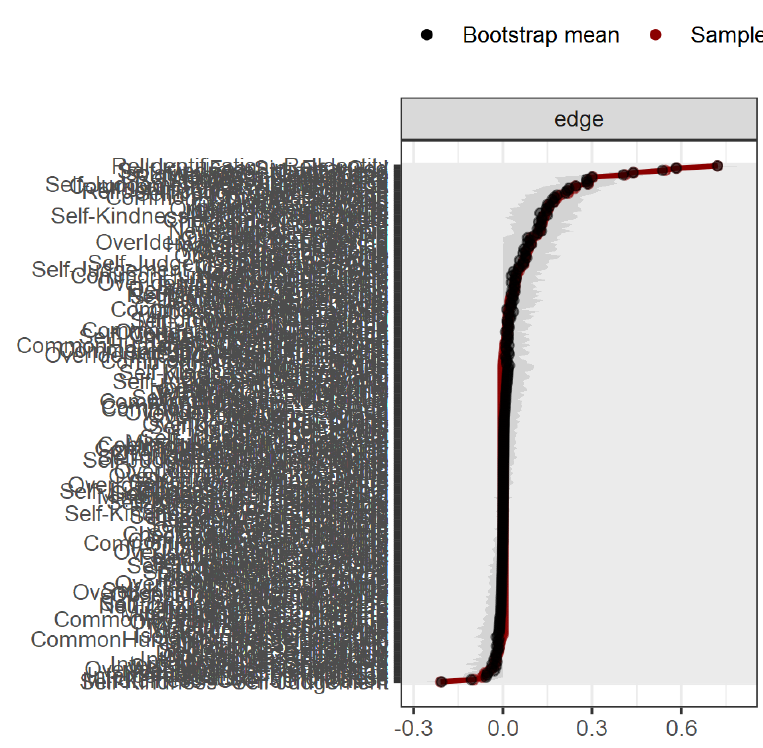
Figure A1. 95% confidence intervals for edges.